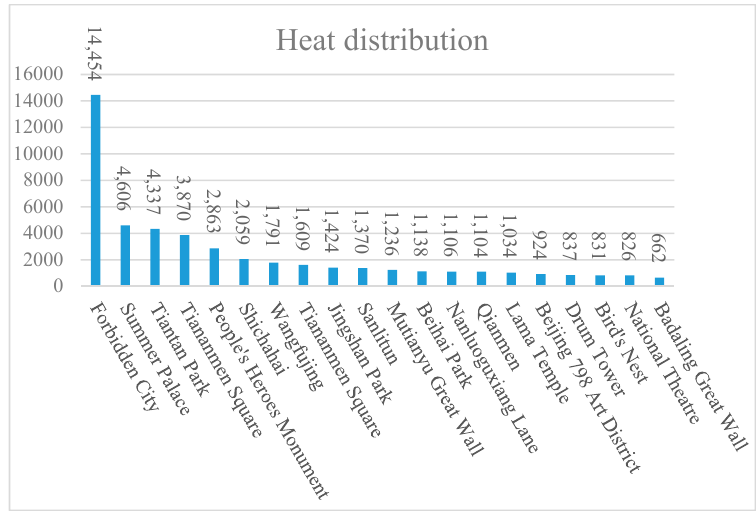
Figure 13. Top 20 popular tourist attractions in Beijing.